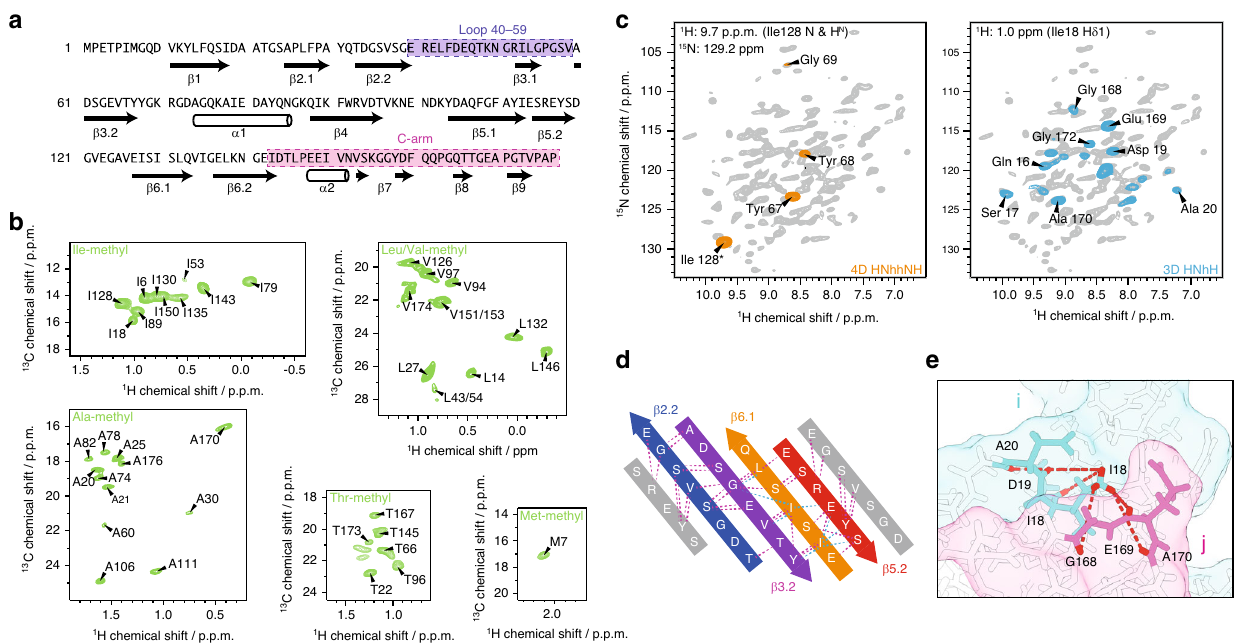
Fig. 1 Solid-state NMR data for hybrid structure calculation de fi nes local structure. a Backbone dihedral angles de fi ne the secondary structure (arrows represent β -sheets, barrels α -helices). The loop (40 – 59) and the C-arm (143 – 176) are highlighted in purple and pink, respectively. b Isoleucine C δ 1-methyl, alanine C β -methyl, leucine/valine C δ /C γ -methyl, threonine C γ 2-methyl, and methionine C ε -methyl labeling renders those moieties NMR-visible and yields highly resolved NMR spectra (green). c Long-range restraints between amide protons are extracted from a 4D HNhhNH spectrum (orange), whereas long- range restraints between amide and methyl groups are extracted from a series of 3D HNhH spectra (blue). 2D planes from both types of spectra are superimposed on a 2D hNH fi ngerprint spectrum (gray). d Representative long-range restraints (dashed lines) de fi ning the inner β -barrel of the tail tube. The colored β -strands belong to one monomer, whereas the gray β -strands are from the neighboring subunits. Amide – amide contacts are highlighted in violet, amide – methyl contacts in cyan. e Schematic representation of long-range distance restraints between the C δ 1 methyl group of Ile18 and amide groups, de fi ning the interface between the N-terminus of one monomer i (including Ile18; in cyan) and the C-arm (143 – 176) of another monomer j (in pink) within the tail tube. Protons are colored in